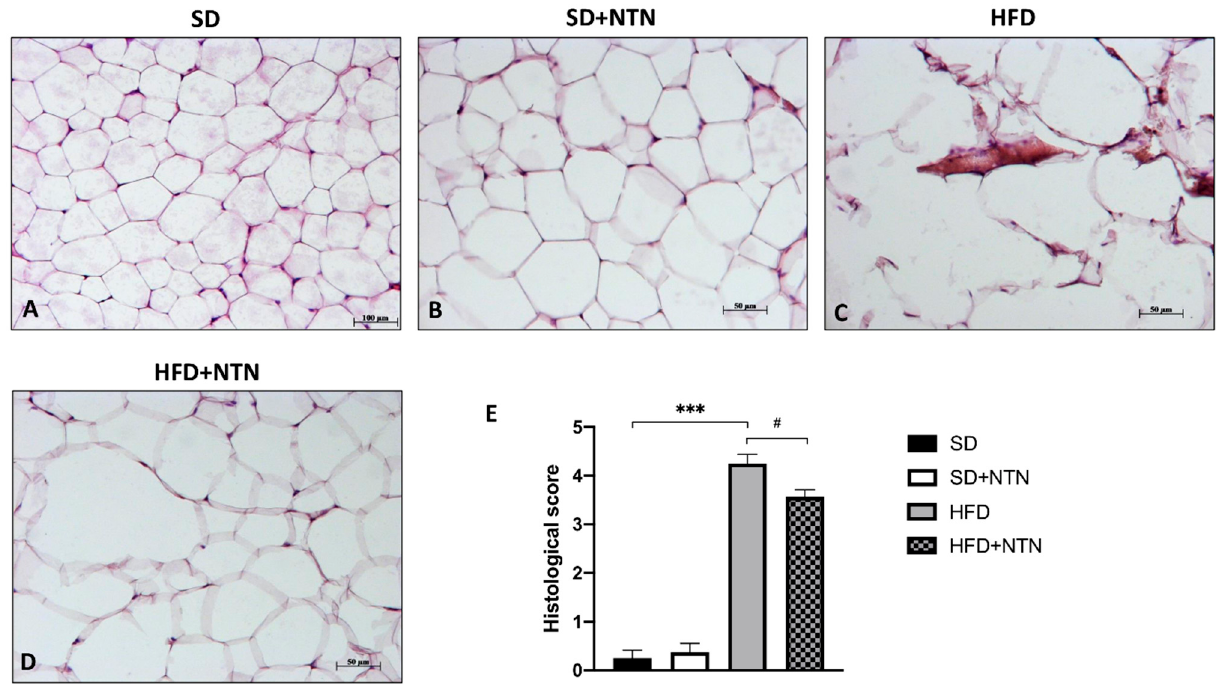
Figure 8. Effects of NTN on adipose damage in HFD mice. HFD led to a remarkable increase in neutrophil infiltration and adipocyte size ( C , E ) compared to SD and SD + NTN mice ( A , B , E ). Administration of NTN was able to significantly counteract the extent of adipose tissue due to HFD ( D , E ). Data are representative of at least three independent experiments. Values are means ± SEM. One-Way ANOVA test. *** p < 0.001 vs. SD; # p < 0.05 vs. HFD.